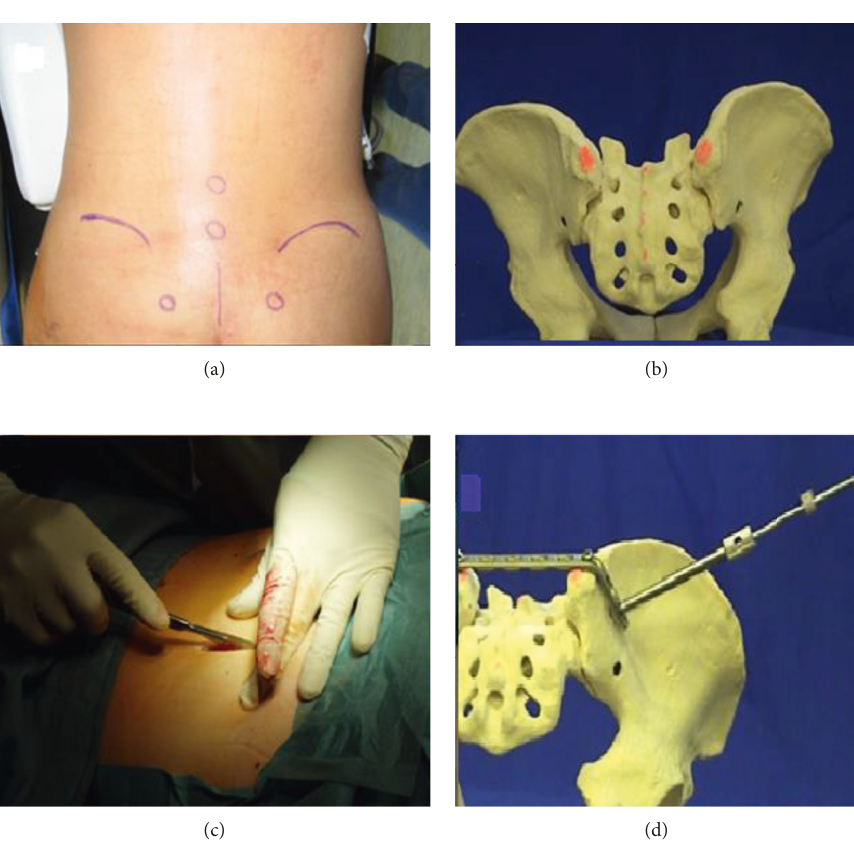
Figure 3: Operating sequence with (a) positioning of the patient, (b) marking of the landmarks, (c) surgical incision, and (d) setting of the angle-stable screws.